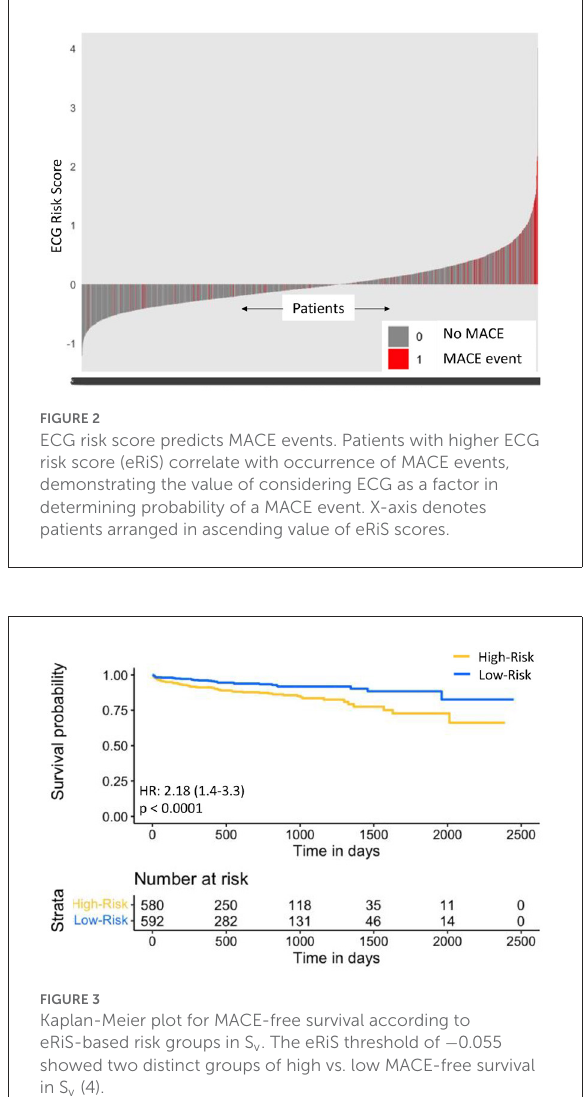
TABLE 1 Patient baseline characteristics.